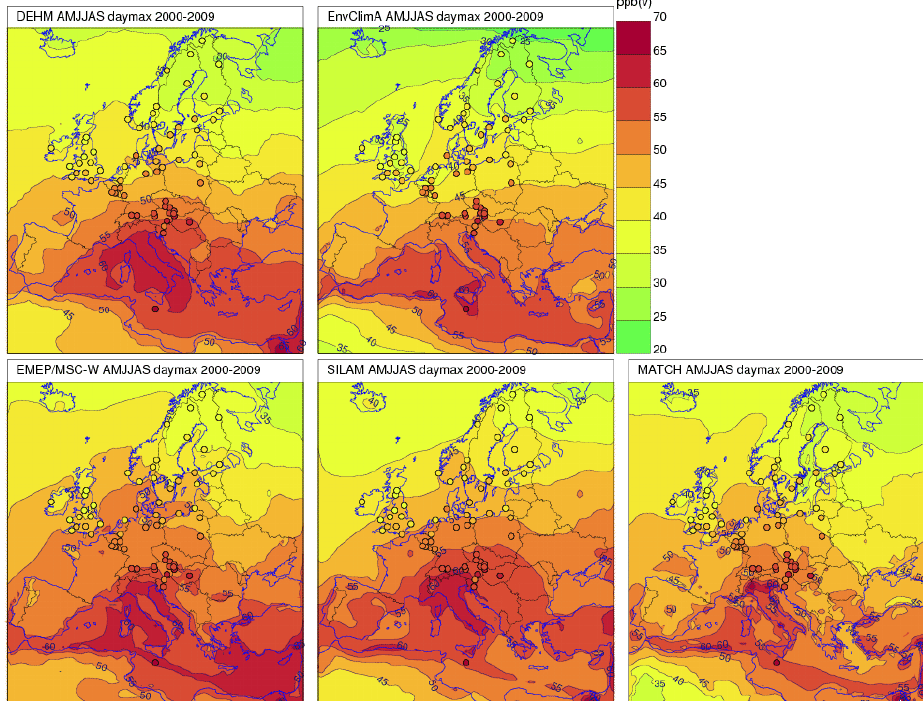
Fig. 8. Simulated April–September average daily maximum O 3 concentration at the lowest model level for the reference period, 2000–2009. Coloured circles indicate the observed values at the stations used in model evaluation given in Table 3. Unitsppb(v).